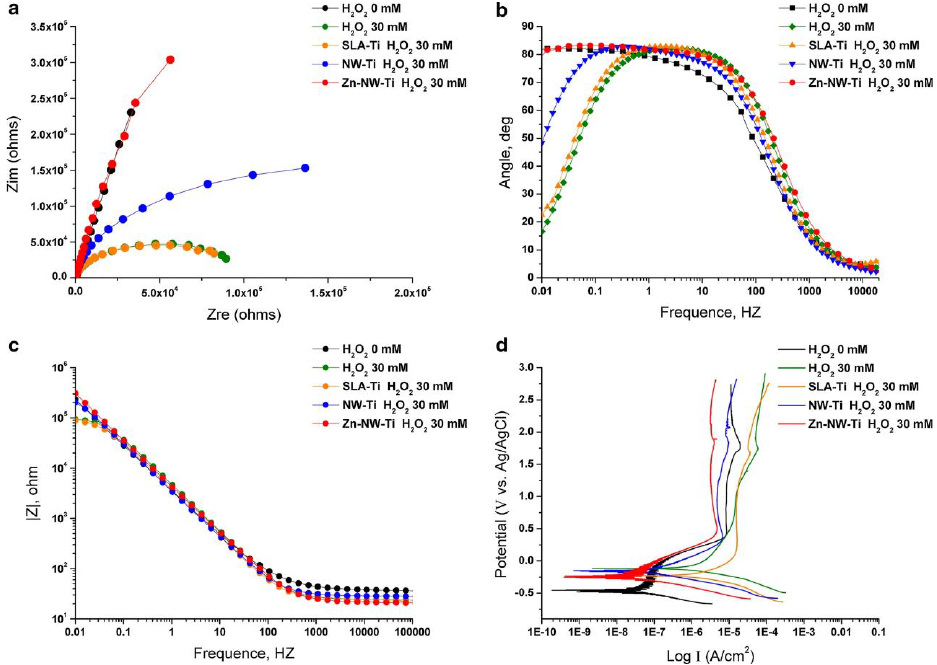
Figure 4. Coating nanowires significantly enhances the corrosion resistance of Ti implants. The electrochemical impedance spectroscopy (EIS) of pure Ti, SLA-modified Ti (SLA-Ti), TiO 2 nanowire- coated Ti (NW-Ti), and Zn-TiO 2 nanowire-coated Ti (Zn-NW-Ti) within 30 mM H 2 O 2 solutions. ( a – c ) The Nyquist plot, Bode Phase, and Bode diagrams show enhanced corrosion resistance of NW-Ti and Zn-NW-Ti. ( d ) The potentiodynamic polarization for varied materials indicates the increased corrosion potential of NW-Ti and Zn-NW-Ti in H 2 O 2 solutions. Reproduced with permission from [71].